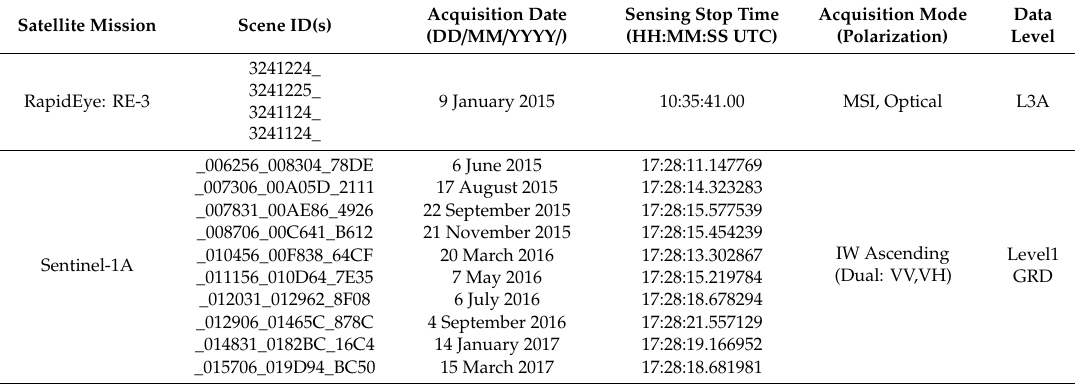
Table 1. The single-date RapidEye image (5 m resolution) and 10 subsample (of the 50 selected initially) multi-date and multi-seasonal Sentinel-1 synthetic aperture radar (SAR) images (10 m resolution). Acquisition Date Sensing Stop Time Acquisition Mode Data Satellite Mission Scene ID(s) (DD / MM / YYYY / ) (HH:MM:SS UTC) (Polarization) Level 3241224_ RapidEye: RE-3